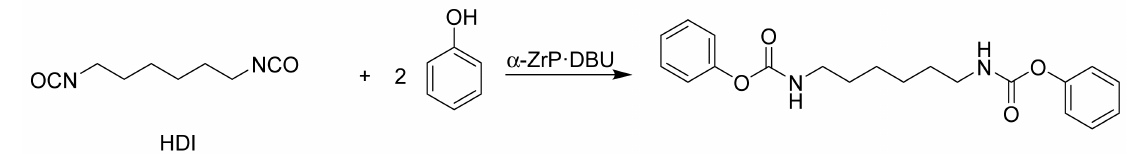
Scheme 1. Reaction of HDI and phenol with α -ZrP DBUs.